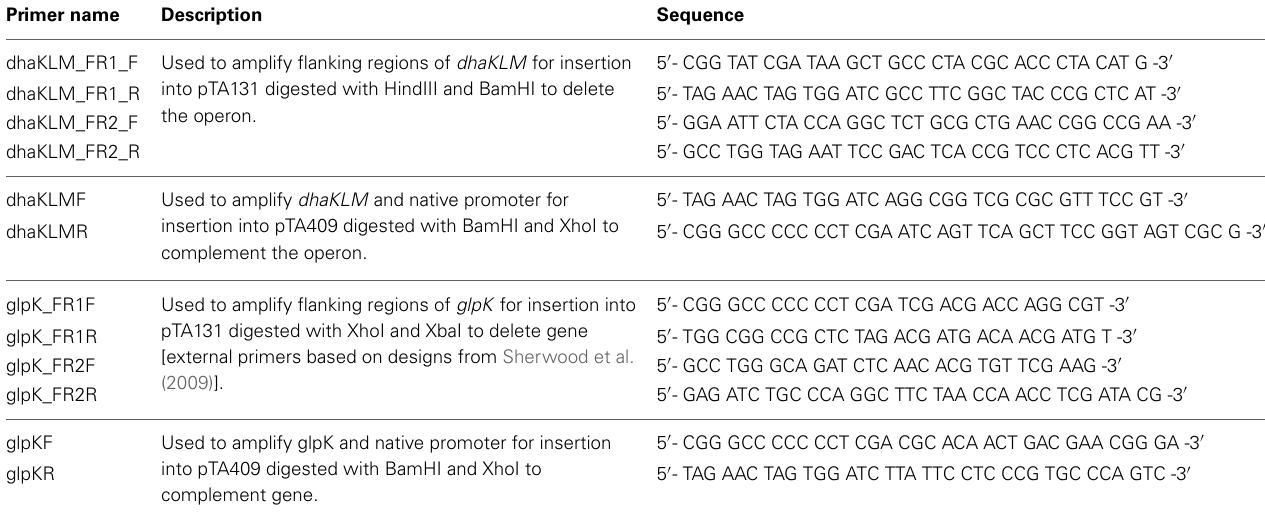
Table 2 | List of primers used in this